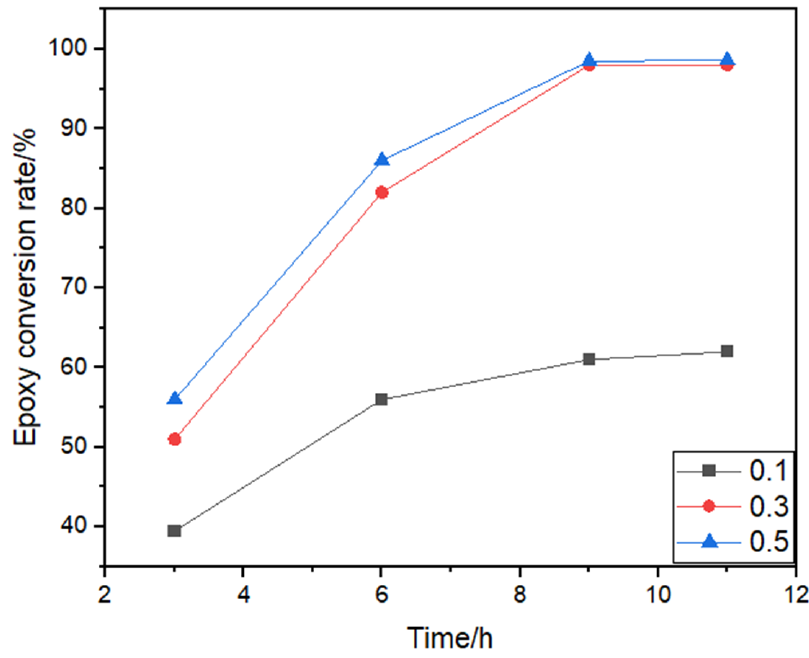
Figure 5. Effect of different amounts of BF 3 ∙ Et 2 O on epoxy conversion rate. (Note: n (PEG1000):n (E20) = 1:1 when discussing the impact of catalyst dosage). Table 3. Effect of different amount of BF 3 · Et 2 O on the stability of the curing agents. (Note: